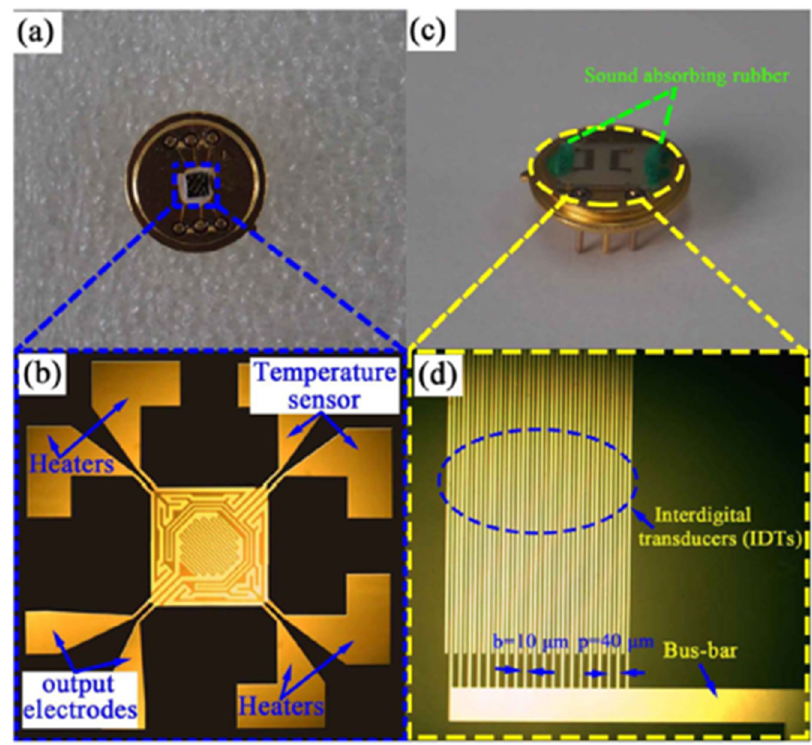
Figure 25. Two kinds of hydrogen gas sensors based on SnO 2 films: ( a ) the chemi-resistive hydrogen gas sensor, ( b ) the micrograph of the chemi-resistive hydrogen sensor, ( c ) the delay-line surface acoustic waves (SAW) hydrogen gas sensor, and ( d ) the micrograph of interdigital transducers (IDTs) of the SAW hydrogen sensor [112]. Copyright (2017), with permission from Elsevier.